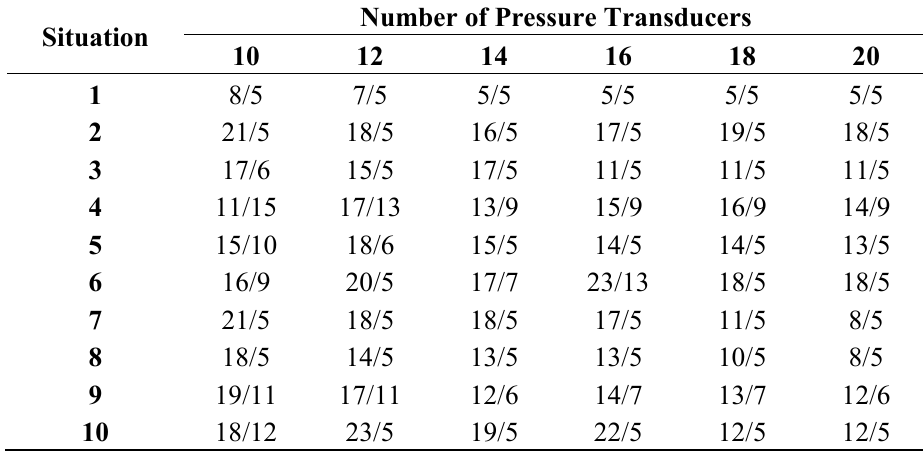
Table 6. Number of reliable leaky pipes in the second WDN (scenario 1/scenario